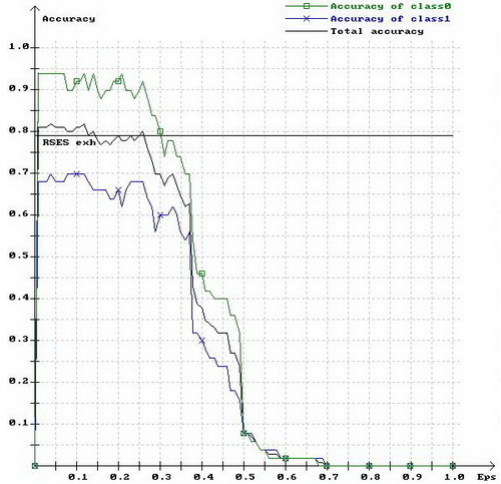
Fig. 2. Results of voting by training objects. Best result for ε = 0.04, accuracy = 0.82, coverage =